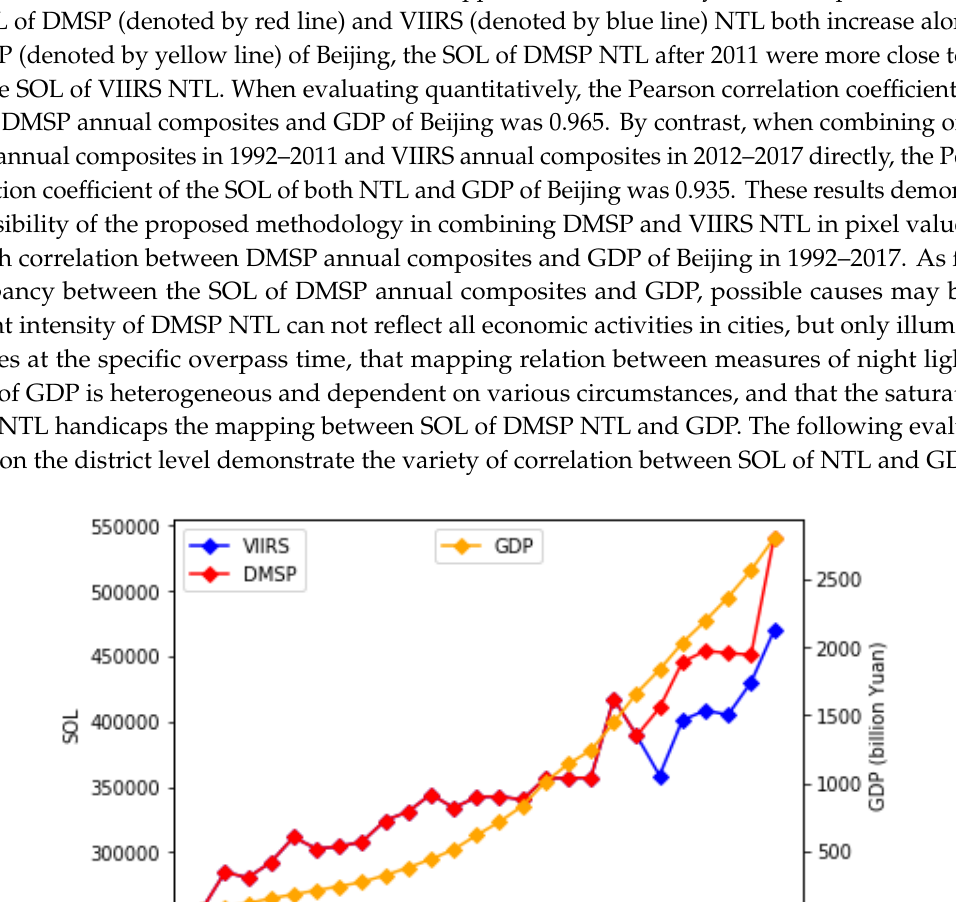
Table 4. Correlation between SOL and GDP of districts in Beijing in 2005–2017. District Without Simulation With Simulation